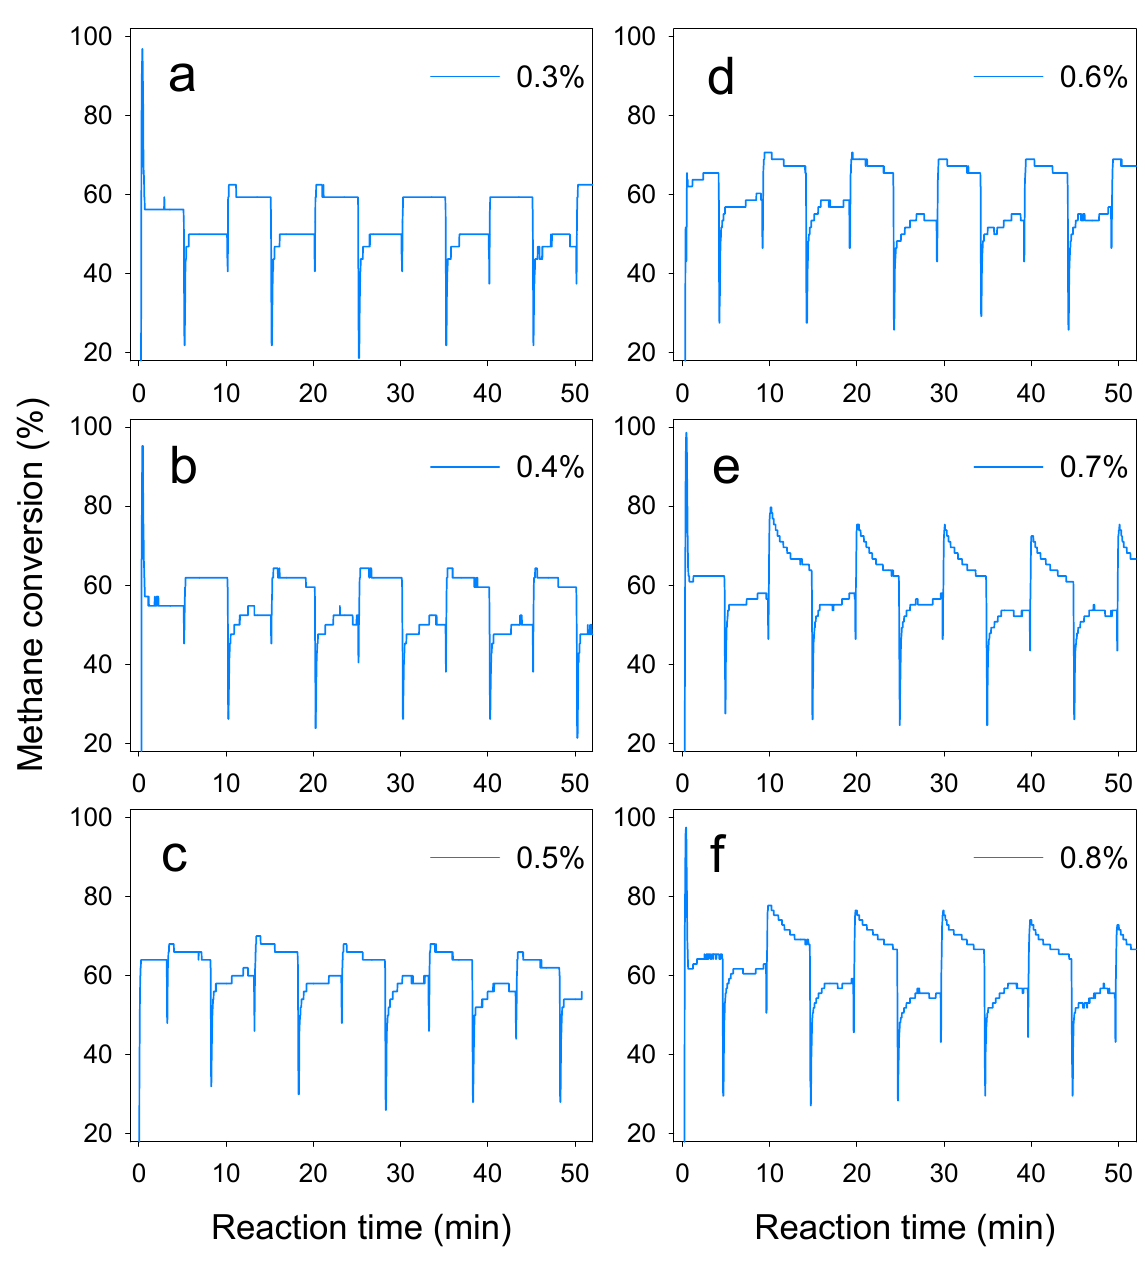
Figure 5. Methane conversion of La 0.8 Sr 0.2 MnO 3 catalyst with different methane inlet concentrations. Start-up conditions: reaction temperature: 800 °C, inlet flow velocity: 1.2 m 3 /h, switch time: 5 min. The methane inlet concentration were ( a ) 0.3%, ( b ) 0.4%, ( c ) 0.5%, ( d ) 0.6%, ( e ) 0.7%, ( f ) 0.8%.